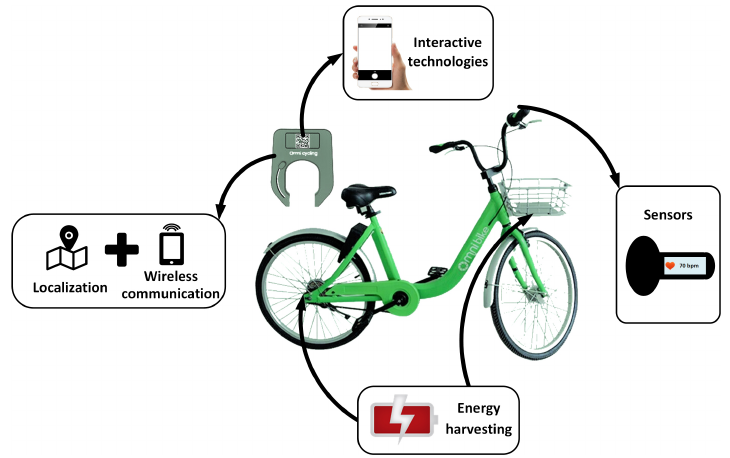
Figure 7. Key technologies in